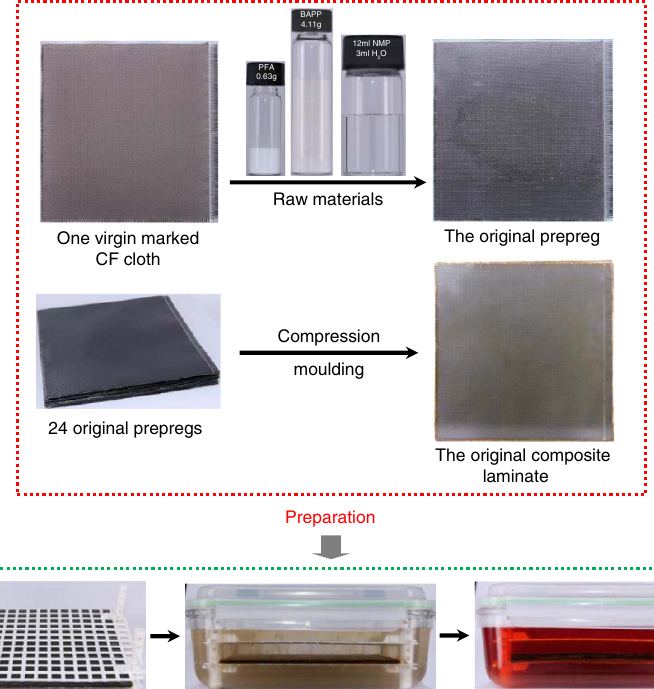
unidirectional CF/PHT composite also displays almost identical mechanical characteristics to an analogous marketed product, Fig. 2e and Table 1b). Similarly, our T300/5405 (unidirectional T300 CF cloth and 5405 BMI resin)